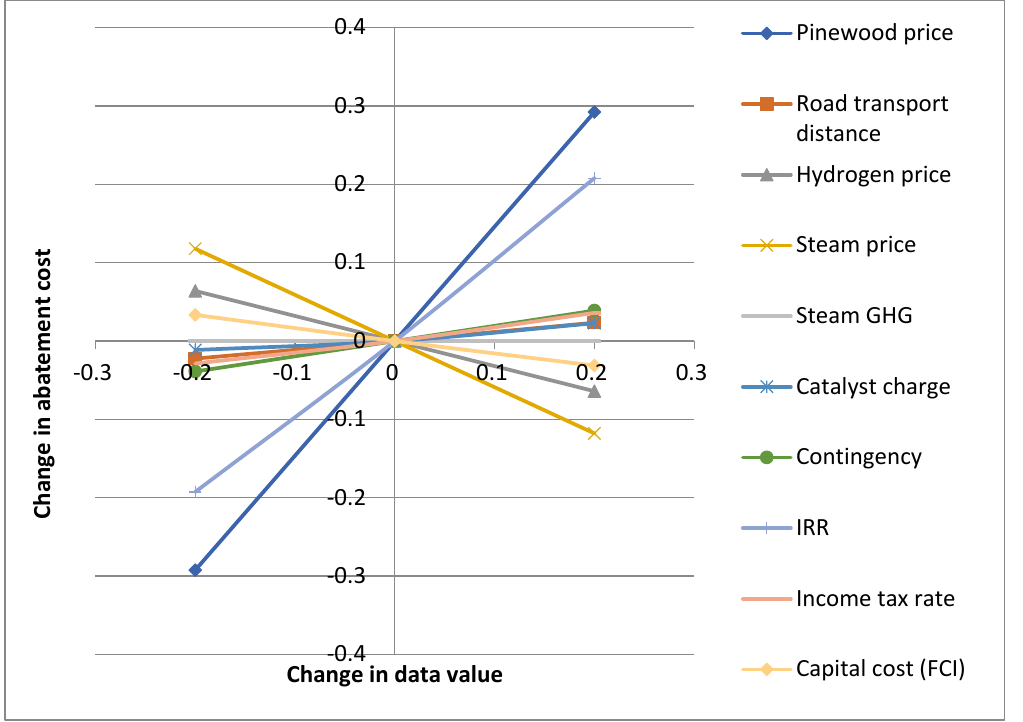
Figure 4. Sensitivity of CO 2 abatement costs to 20% variation in data inputs for the HT_Oil_Cs / ASA case.